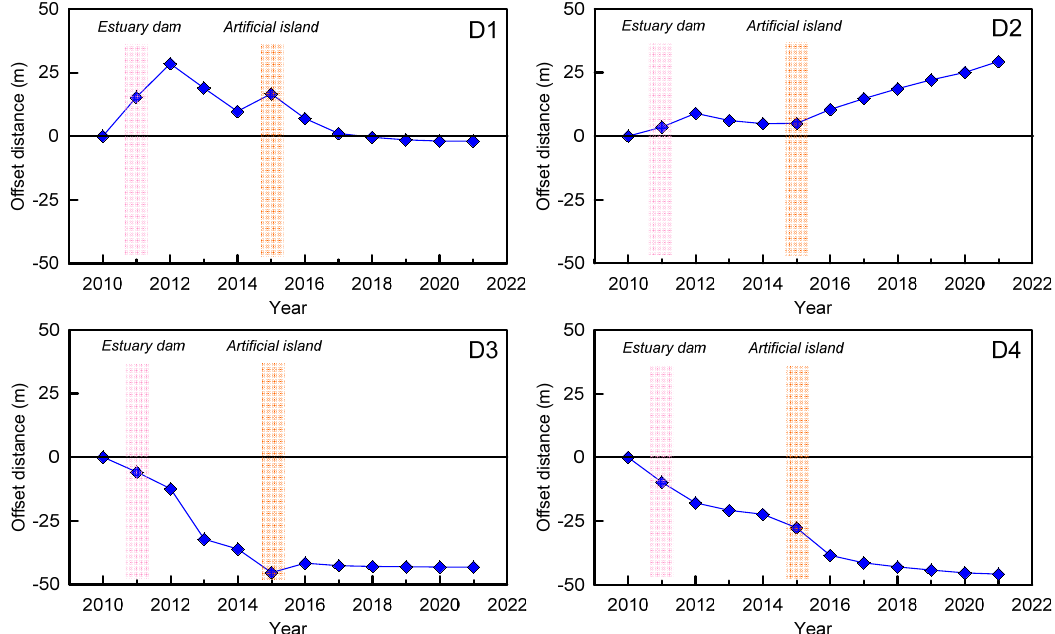
Figure 6. Longitudinal offset of the FESL at four sections. See Figure 1 for the section positions. Pink bands represent the construction of the estuary dam, and brown bands represent the construction of the artificial island. Positive values indicate migration toward the sea, and negative values indicate migration toward the land.